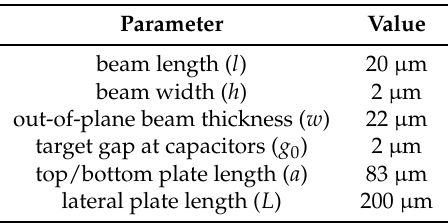
Figure 1. SEM picture of the on-chip testing device, with a close-up of the polysilicon beam sample. Table 1. Dimensions of the on-chip testing